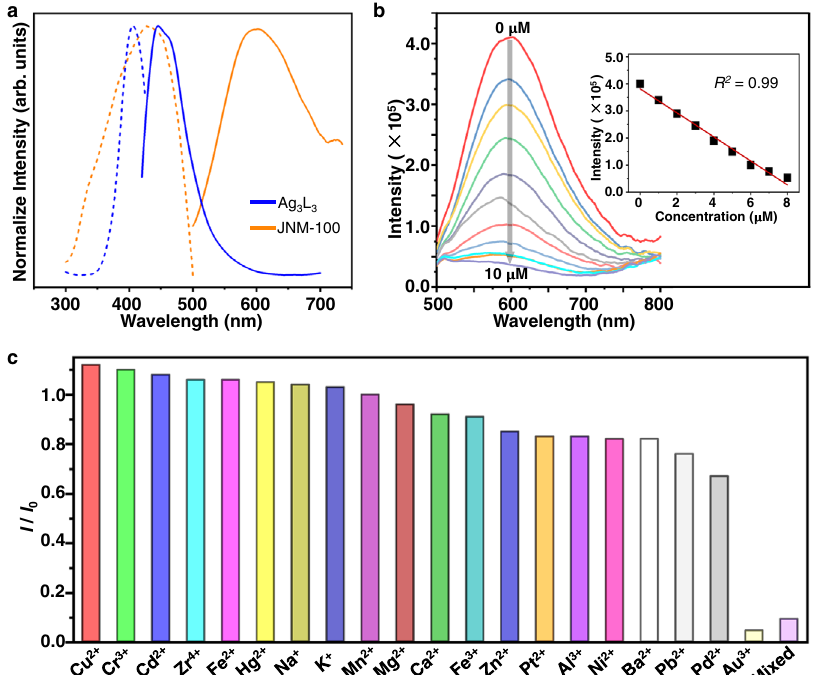
Fig. 3 | Photoluminescent (PL)and selective detectionofgold ions ofJNM-100. a Excitation emission spectra of Ag 3 L 3 and JNM-100 (blue and orange present PL spectra of Ag 3 L 3 and JNM-100, respectively; dashed and solid lines represent excitation and emission spectra, respectively). b Fluorescence spectra of JNM-100 inthepresenceofanincreasingconcentrationofAu(III)(from0to10 μ M)inwater